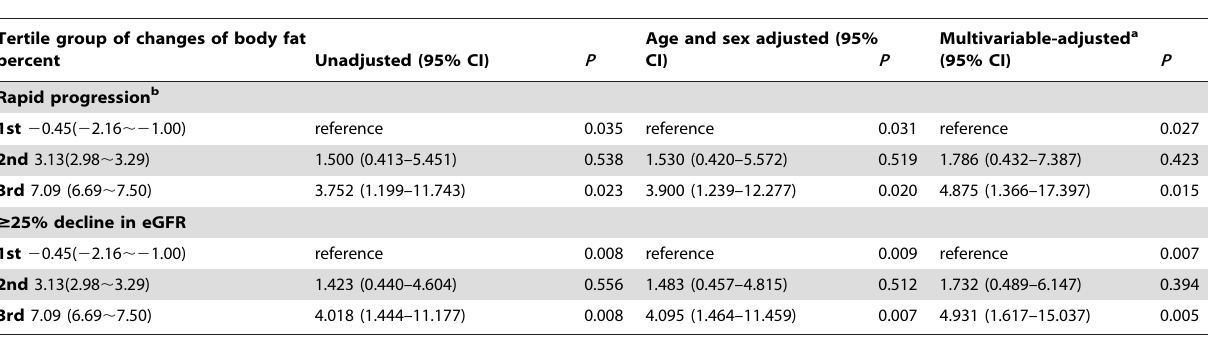
Table 3. Odds ratio for renal outcome according to the changes of body fat.